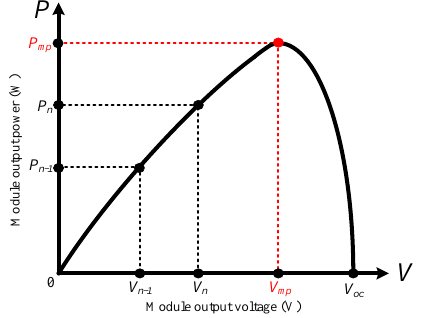
Figure 4. P-V curve of photovoltaic (PV) module.